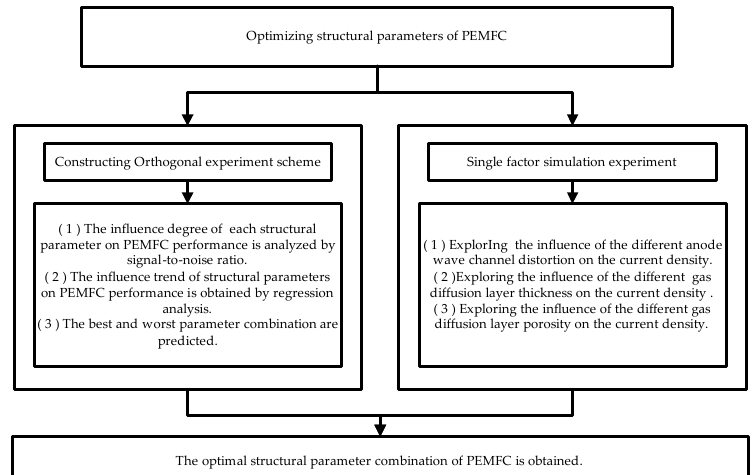
Figure 5. Flowchart of analysis and optimization process.